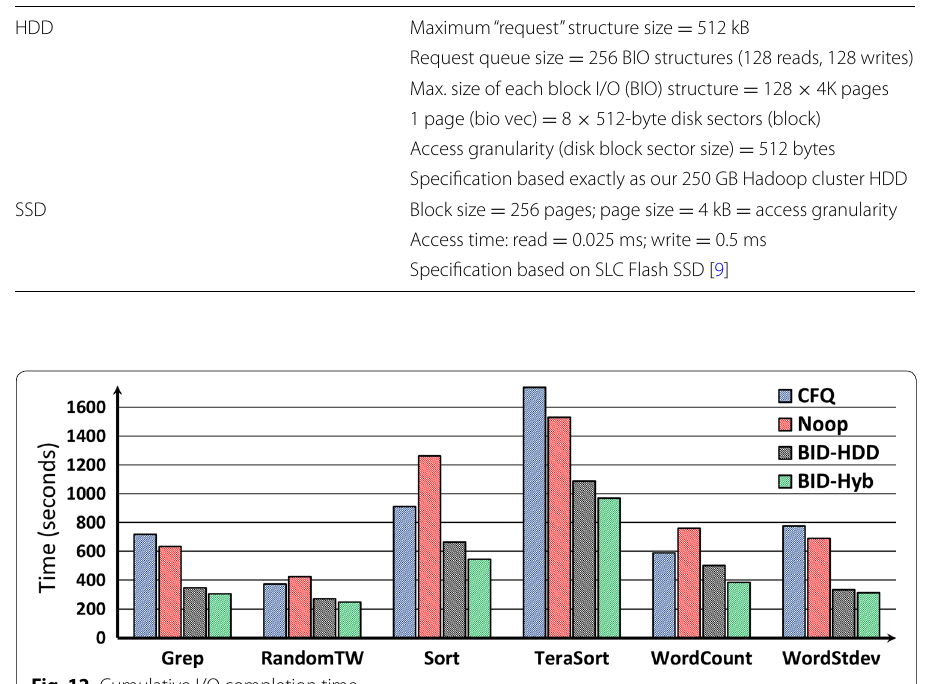
Table 3 Block device parameters in use for performance evaluation Block device